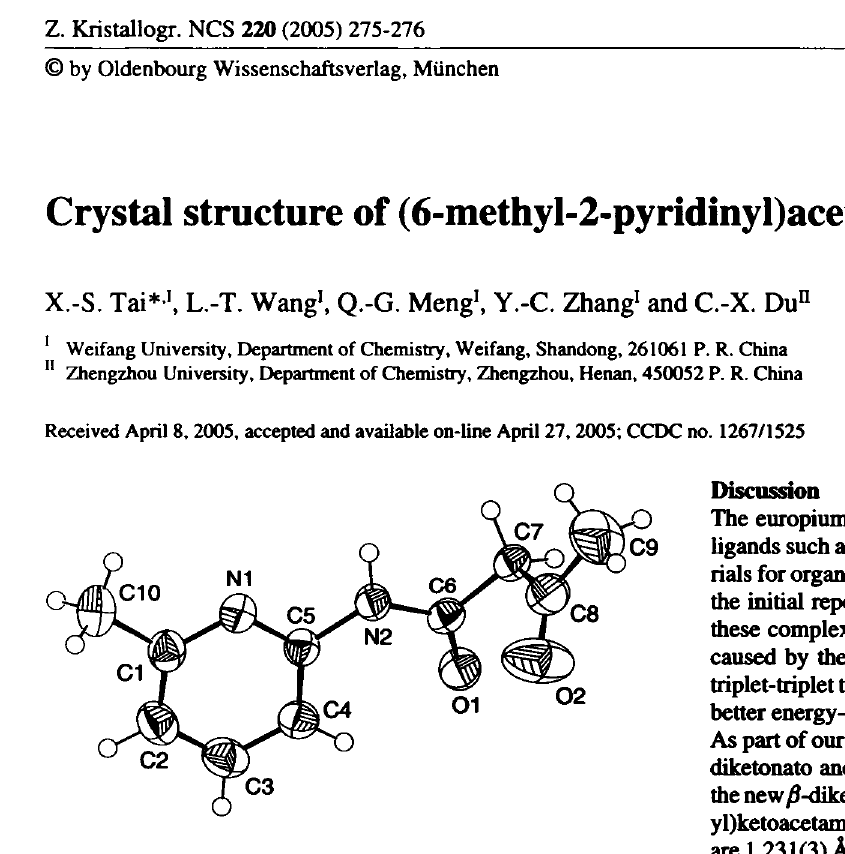
Table 1. Data collection and handling.